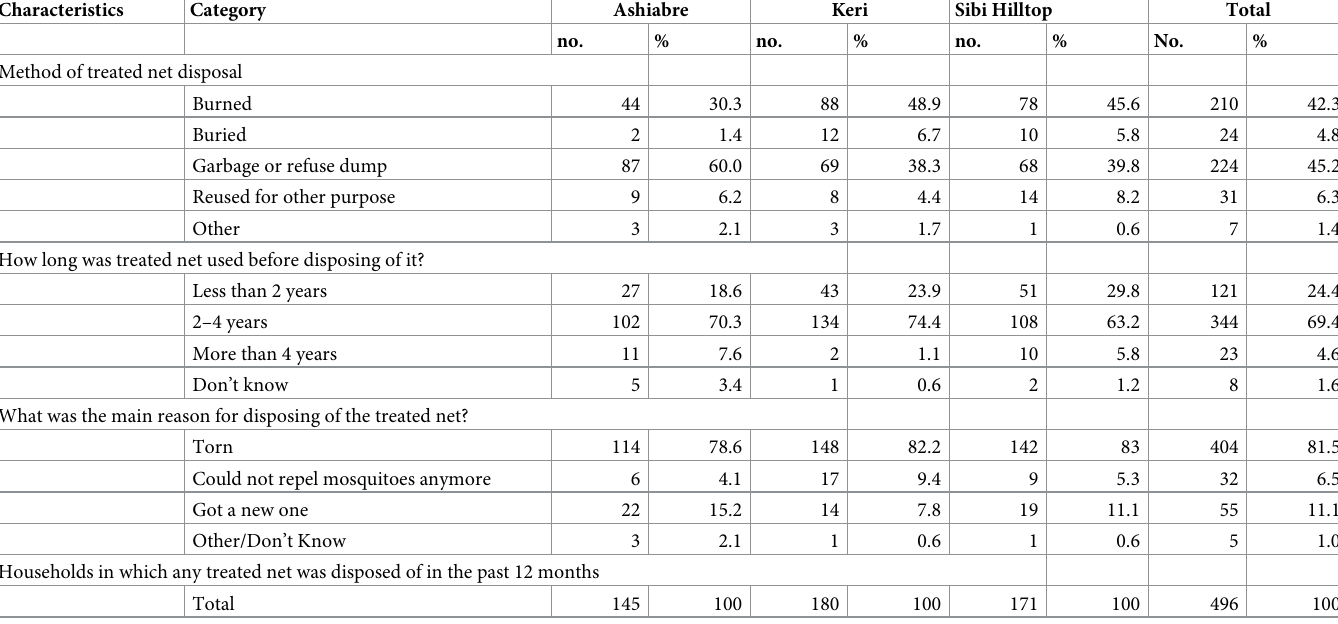
Table 6. Methods of ITN disposal, duration of ITN use before disposal, and reason for ITN disposal. Characteristics Method of treated net disposal